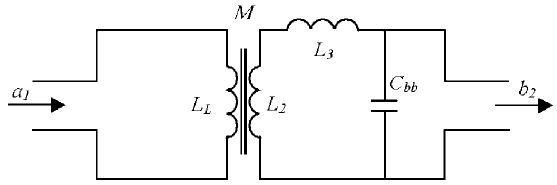
FIG. 11. Transformer model for S twin-wire line and the